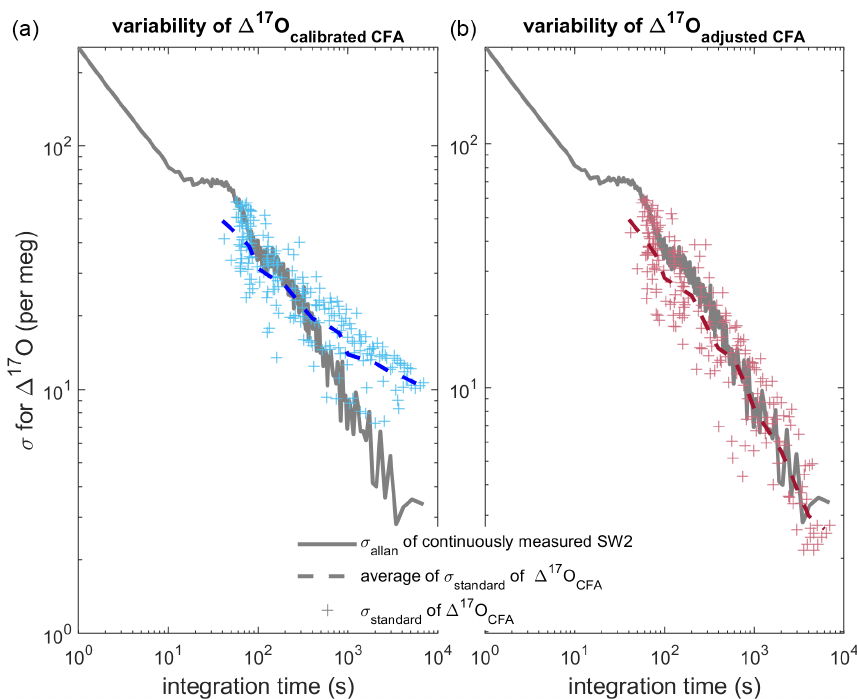
Figure 7. Comparison of Allan deviation of continuous reference water measurements and standard deviation of nine duplicate CFA ice-core measurements. In both panels (a) and (b) , the Allan deviation line (solid grey) for a long measurement of SW2 is overlain by the standard deviation of the CFA–CRDS ice-core measurements (crosses) and the mean of the standard deviations for each integration time (dashed line). The (cid:49) 17 O calibratedCFA and (cid:49) 17 O adjustedCFA data are shown in blue and red similarly to Figs. 5 and 6. The standard deviation on the left is calculated from calibrated replicate CFA–CRDS measurements and shows the total variability between CFA–CRDS replications along the depth of the core. The standard deviation information in the right plot is calculated from calibration-adjusted datasets so that the effect of the calibration offset error is removed; this analysis is still dependent upon instrumental noise, CFA errors, depth registration errors, and natural variability within the